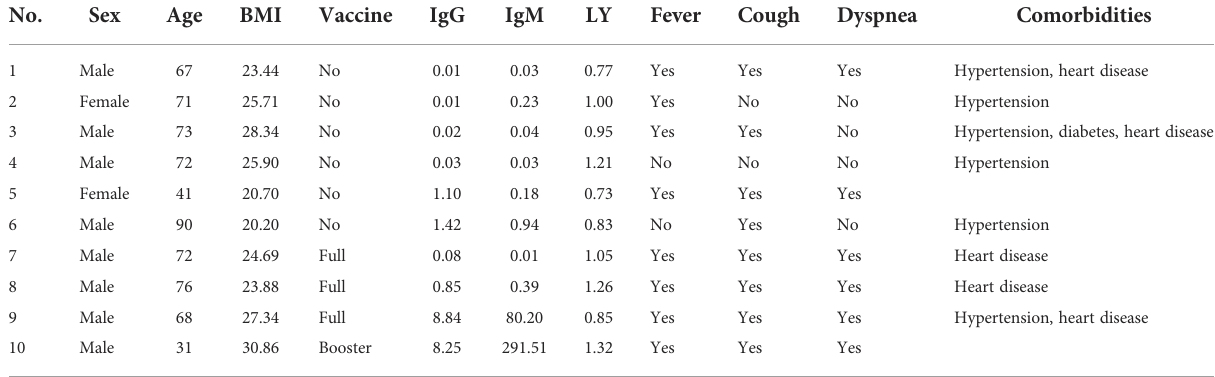
TABLE 4 Clinical characteristics of 10 severe